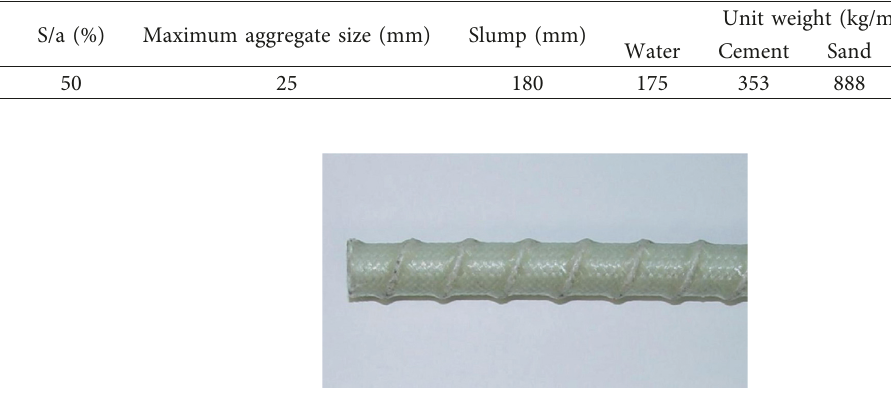
Table 1: Mix proportions of concrete used in this study.